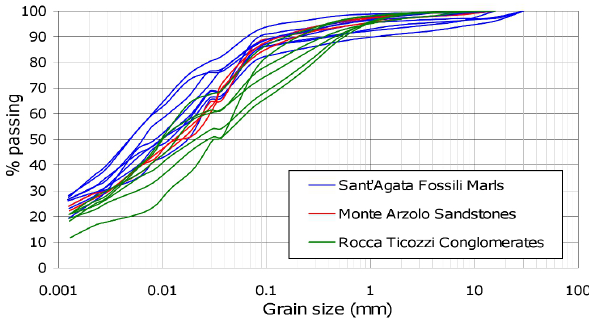
Fig. 5. Grain size distribution curve of